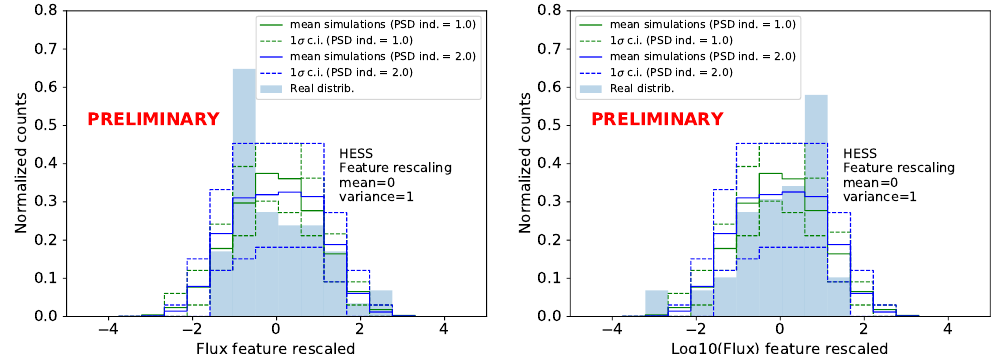
Figure 4. Distribution of the rescaled flux for the H.E.S.S. 4-min-wise light curve compared with estimates from Gaussian ( left panel , 1000 simulations) and log-normal ( right panel , 1000 simulations) simulations. The colour codes are the same as in Figure 2. In this case there seems to be only a slight preference for a log-normal behaviour with respect to a normal one, but neither distributions explain well the